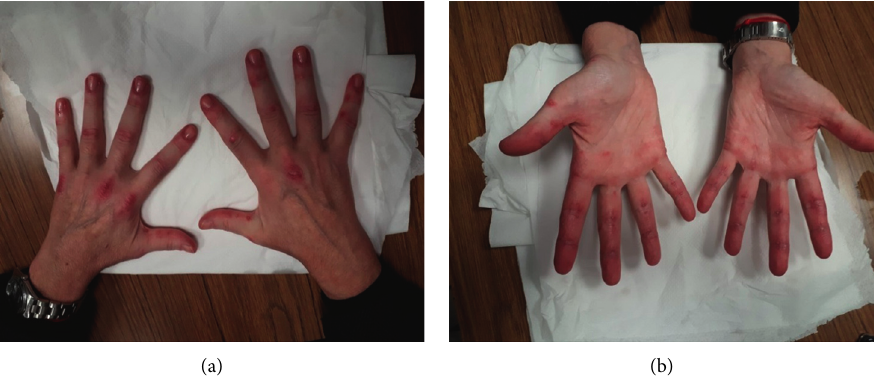
Figure 1: Papular erythematosus lesions on both the palmar and dorsal surface of the patient’s hands.